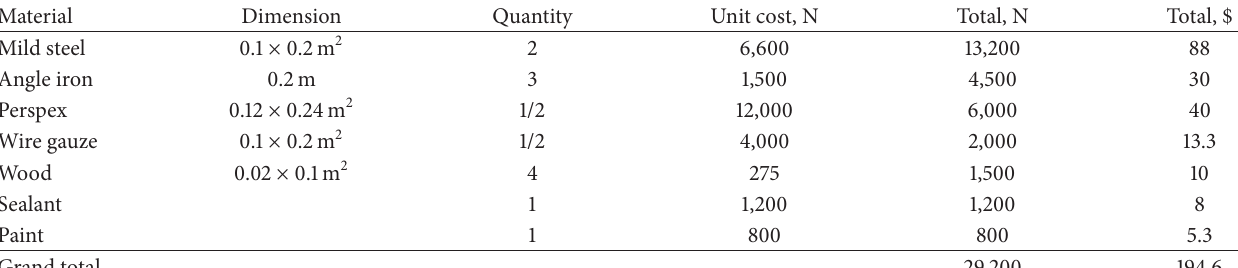
Table 4: Cost of constructing a unit solar